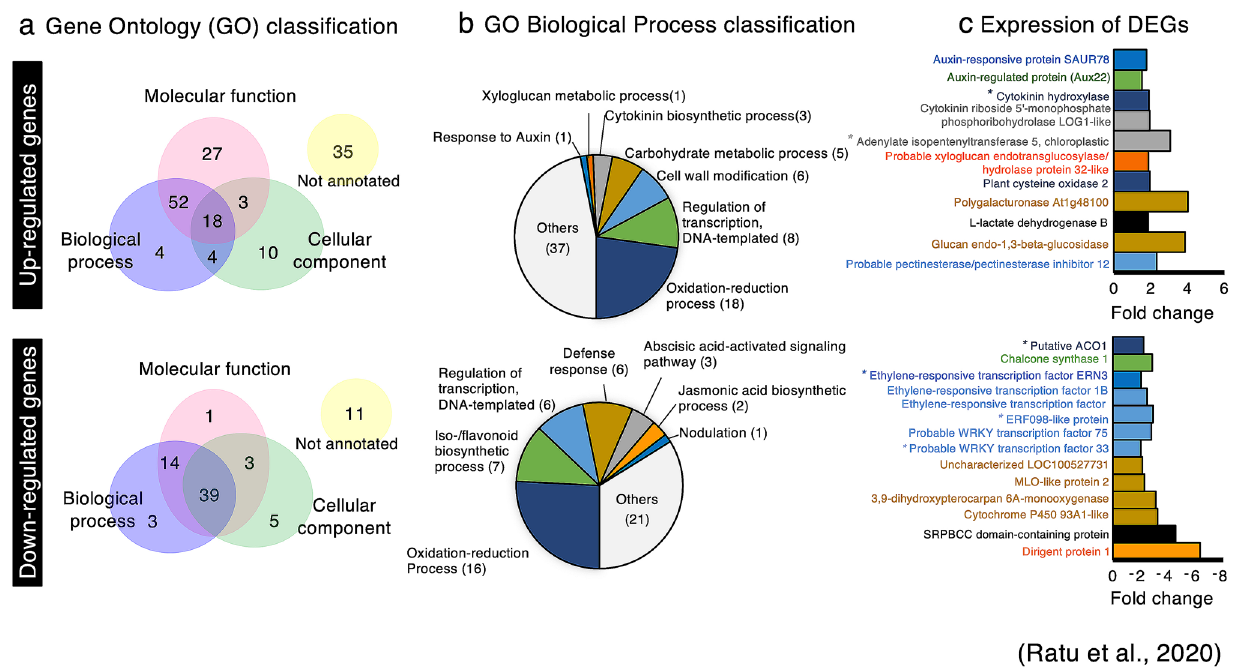
Figure 6. Soybean genes differentially expressed by the B. elkanii T3 effector Bel2-5. ( a ) Gene ontology classification of the soybean genes up- or down-regulated during interaction with B. elkanii wild-type as compared with bel2 -5 deletion mutant. To detect the soybean genes that were up-regulated and down-regulated, RNAseq fold in the roots of En1282 inoculated with USDA61 wild-type were compared to the roots of En1282 inoculated with bel2-5 deletion mutant. The soybean genes with signal intensities ≥ 1.5-fold and ≤ 0.5-fold were considered to be up-regulated and down-regulated, respectively. ( b ) GO classification on biological process (GO_BP) of soybean DEGs. Several DEGs were annotated into multiple classes of GO_BP. ( c ) Characteristics of several down-regulated and up-regulated of soybean genes. The bar’s color represents in where gene was annotated in GO_BP. The bar with black color represents gene was annotated into multiple classes of GO_BP. See Supplementary Table 3 and 4 for the details ( b , c ). Asterisk (*) means representative DEGs were validated with qRT-PCR (Supplementary Fig.